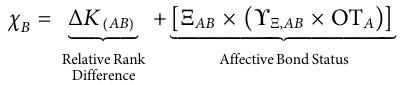
Receiving Aggression ( Section 2.2.3.1